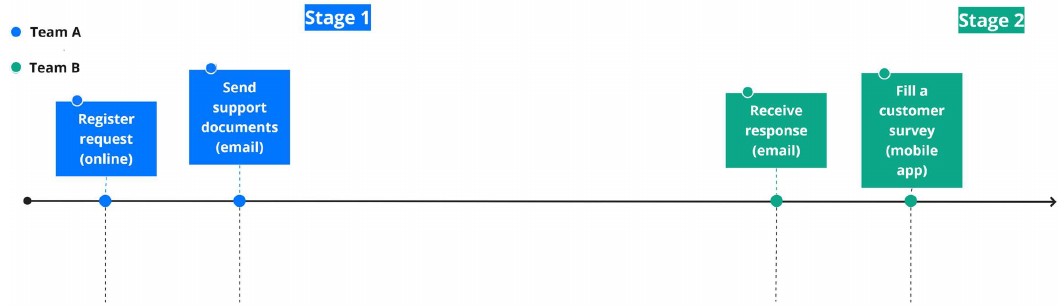
Figure 1. Example of the sequence of frequent activities in a customer service